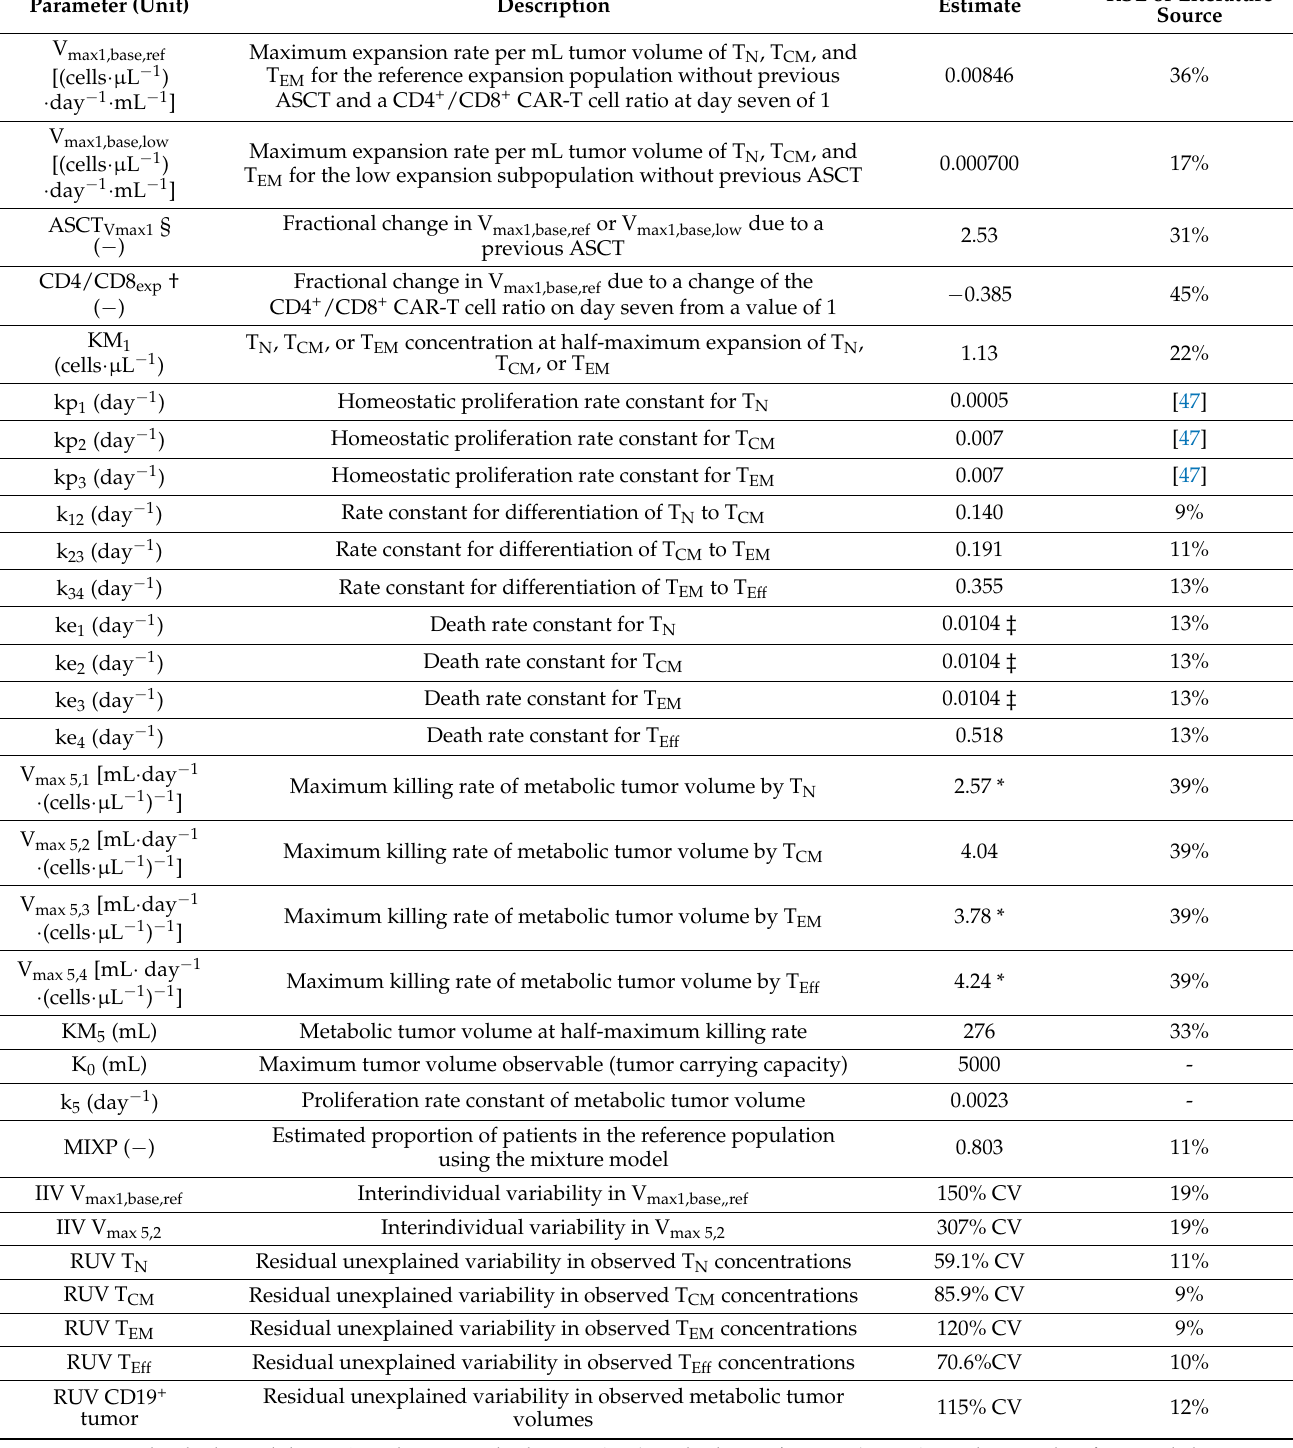
IIV: interindividual variability; RSE : relative standard error, % = (standard error/estimate) · 100; §: implemented as fractional change covariate model, †: implemented as power covariate model; ‡ derived using the estimated death rate constant for effector T cells ke 4 and the relationship between death rate constants of short- and long-lived T cells in the publication by Stein et al. [21]; * derived using the estimated maximum killing rate of metabolic tumor volume by T CM and the digitized relationships of tumor cell killing rates in the publication by Schmueck-Henneresse et al.